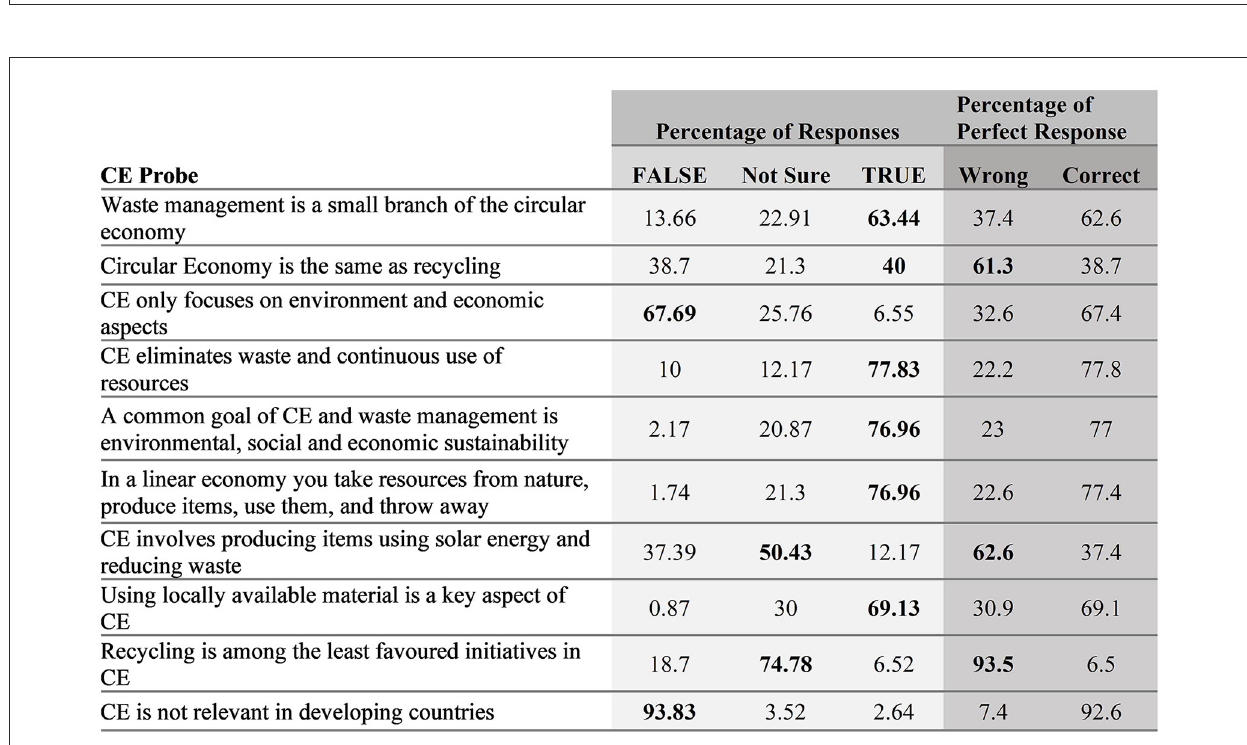
FIGURE5 Statements to test respondents CE